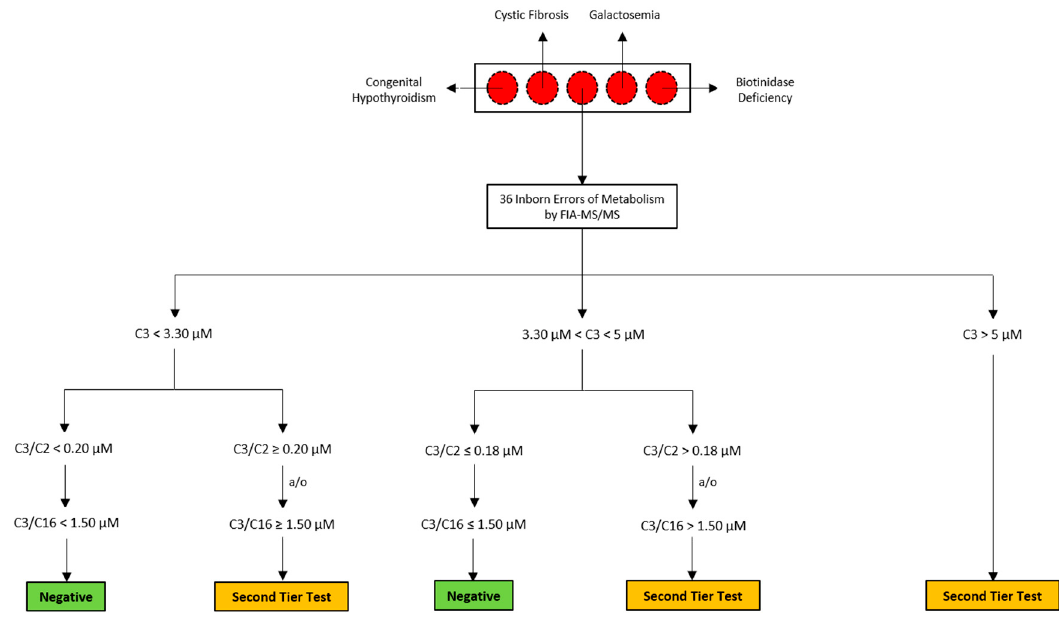
Figure 1. Workflow of the second-tier test strategy in the management of C3 alterations.